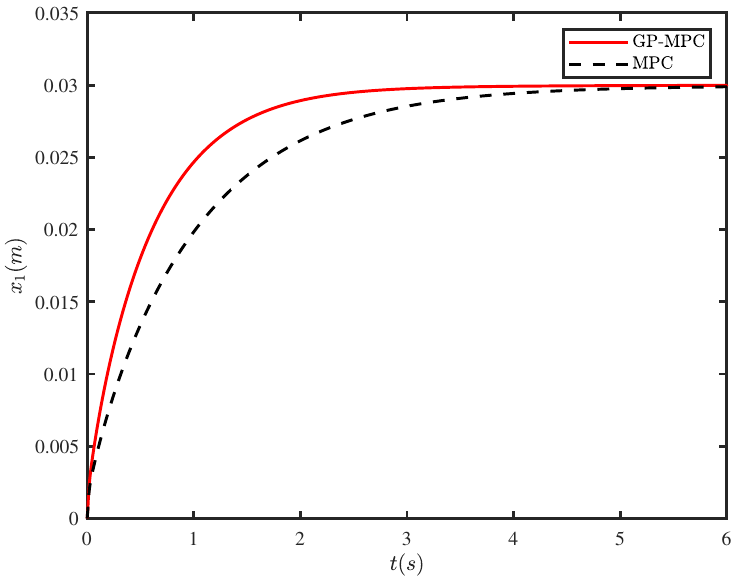
Figure 7. Position control under different